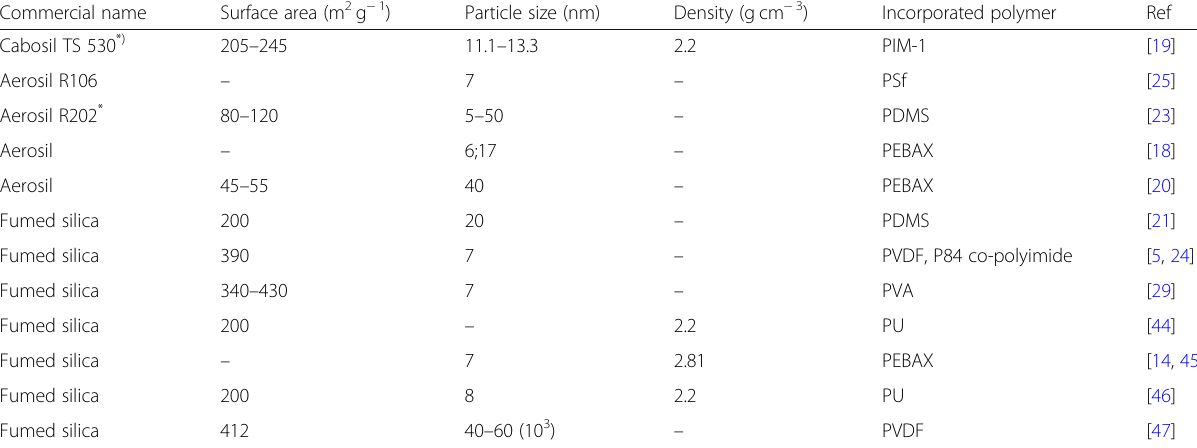
Table 1 Non-porous silica for mixed matrix membranes (MMMs)